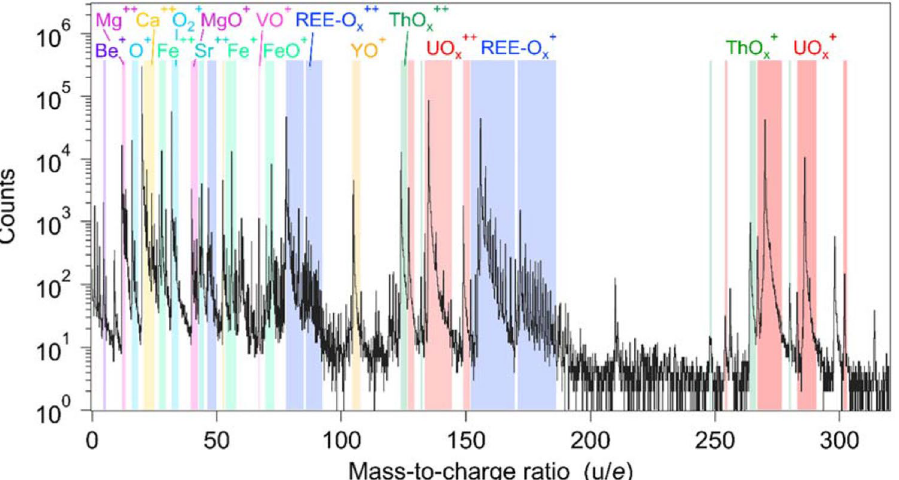
Figure 6. Atom probe tomography (APT) selected mass spectrum for the U-REE phase. Major ionic peaks are identified.